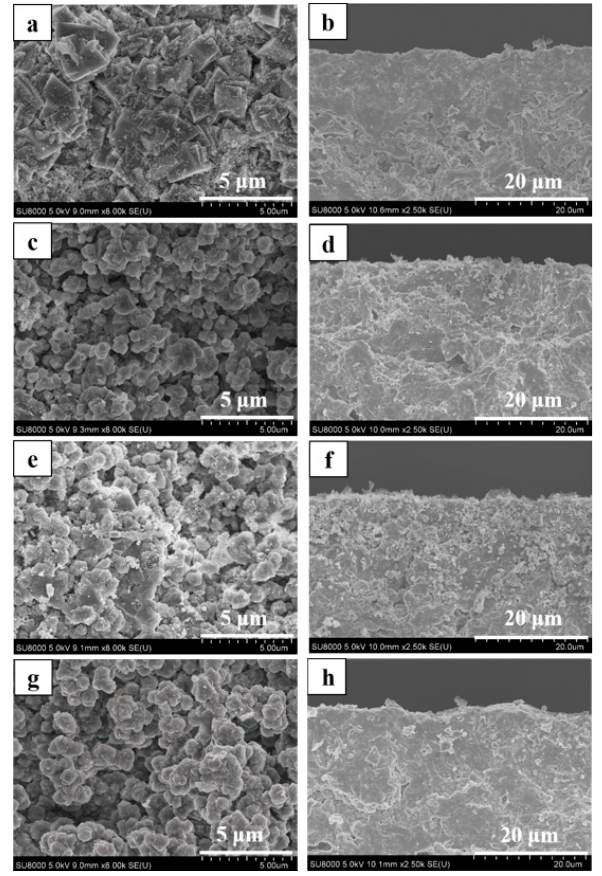
Figure 5. Surface and cross-sectional SEM images of high silica SSZ-13 zeolite membranes with different H 2 O/SiO 2 ratio, ( a , b ) M-4, H 2 O/SiO 2 = 20; ( c , d ) 40, H 2 O/SiO 2 = 40; ( e , f ) M-6, H 2 O/SiO 2 = 60; ( g , h ) M-3, H 2 O/SiO 2 = 80.